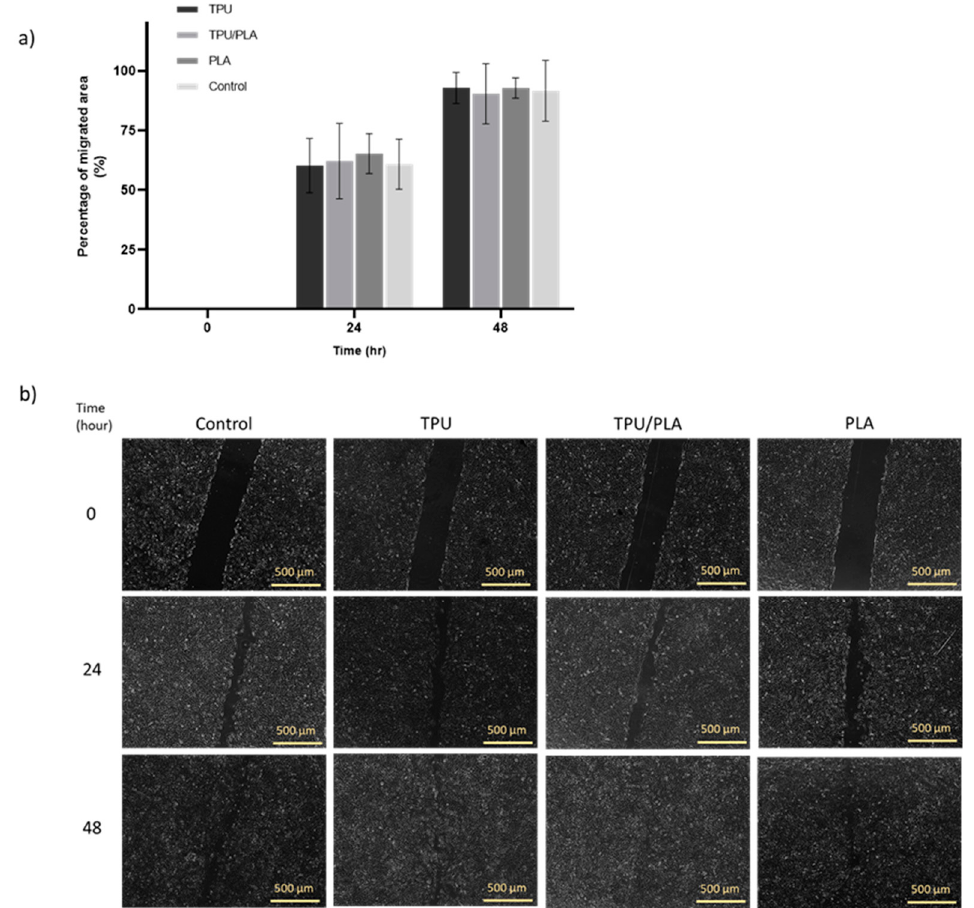
Figure 4. ( a ) BEAS-2B cell scratch analysis. ( b ) The effects of extracts from the 3D printed scaffolds on the migration of BEAS-2B cells. The scratches were made and the cells were treated with different scaffold extracts. Images of the wound area were taken 0, 24, and 48 h after treatment and measured using ImageJ analysis software. Scale bar: 500 µm.